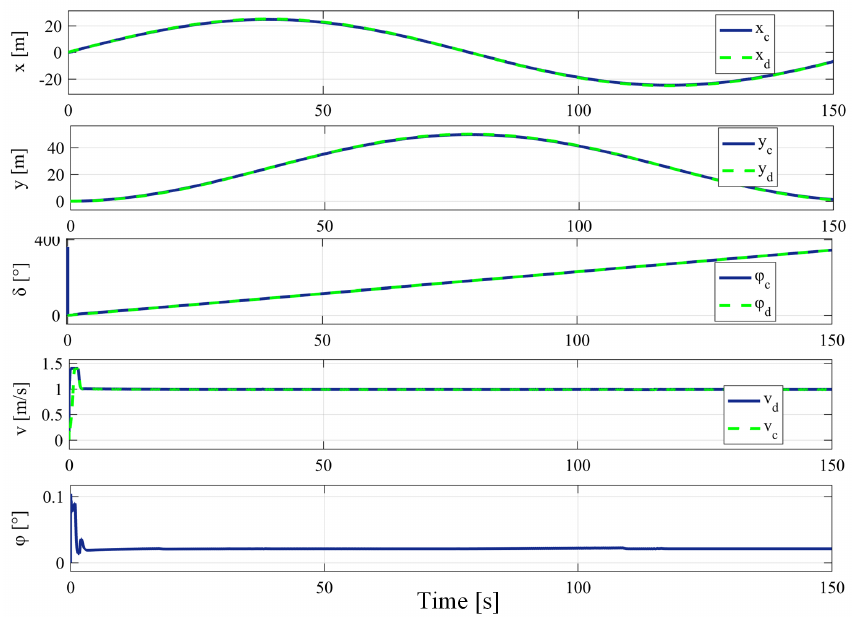
Figure 14. Longitudinal position, lateral position and heading angle, slip angle, yaw rate and heading angle.